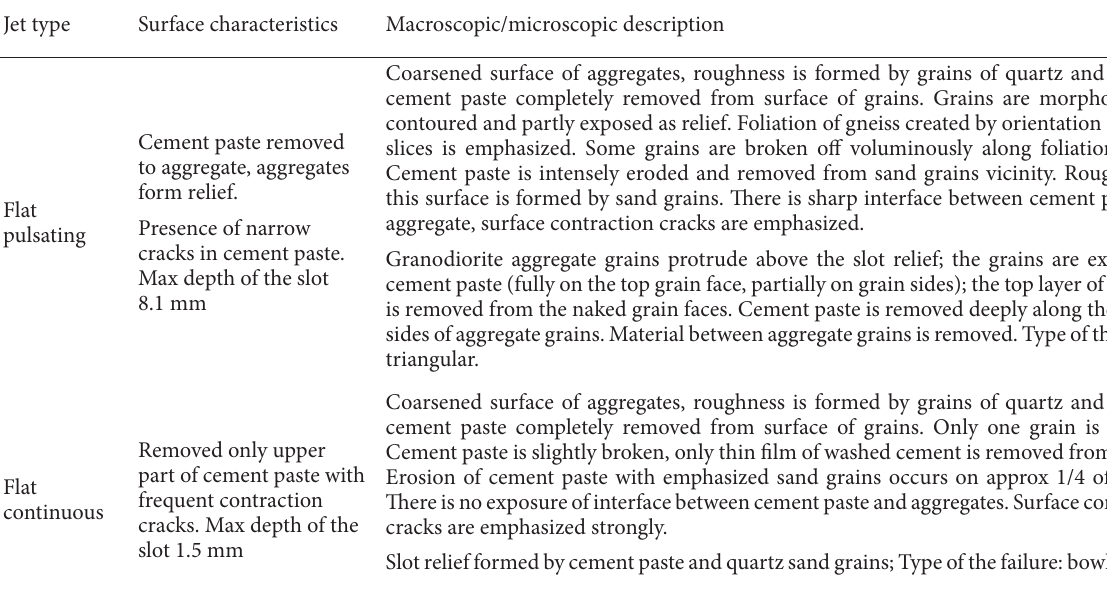
Table 3. Description of newly created surface after water jet treatment Jet type